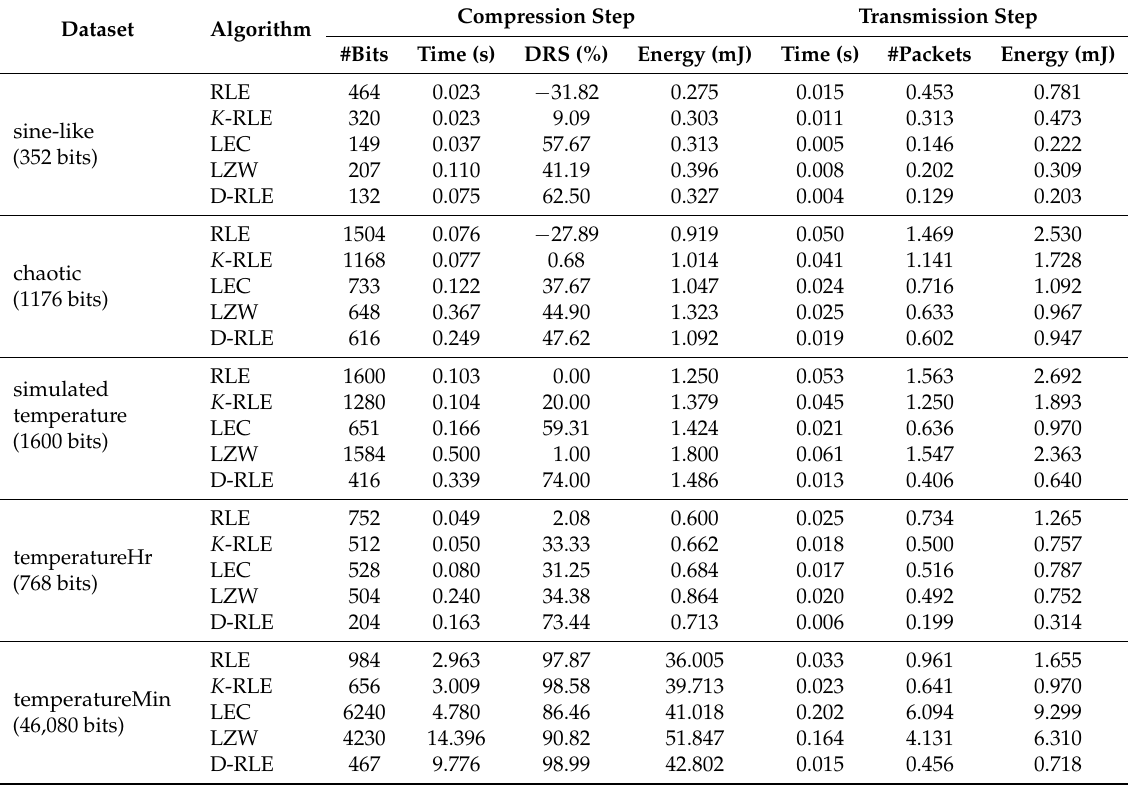
Table 5. Comparison between compression and transmission steps for datasets with different